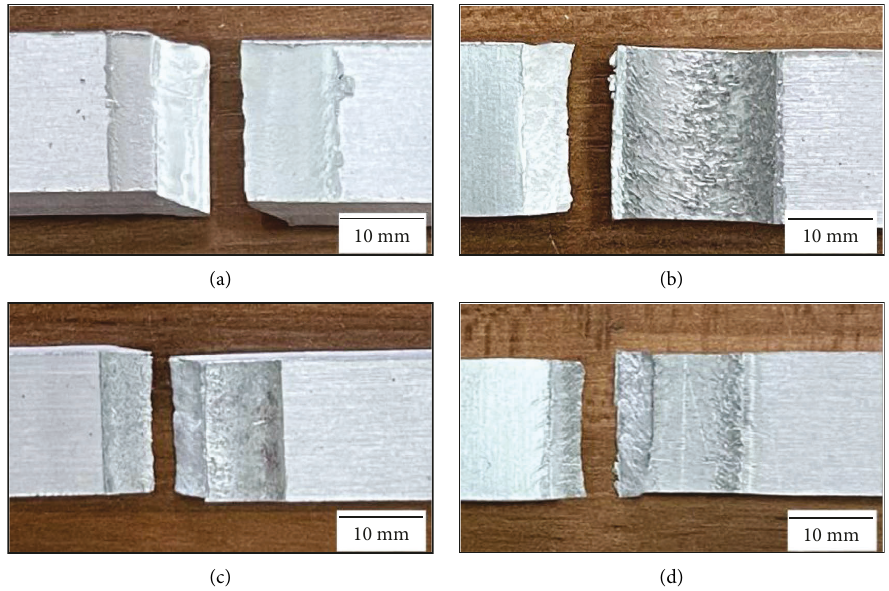
Figure 10: Fracture locations of minimum and maximum tensile strength. DS-FSW at (a) 36mm/min and (b) 102mm/min. SS-FSW at (c) 216mm/min and (d)